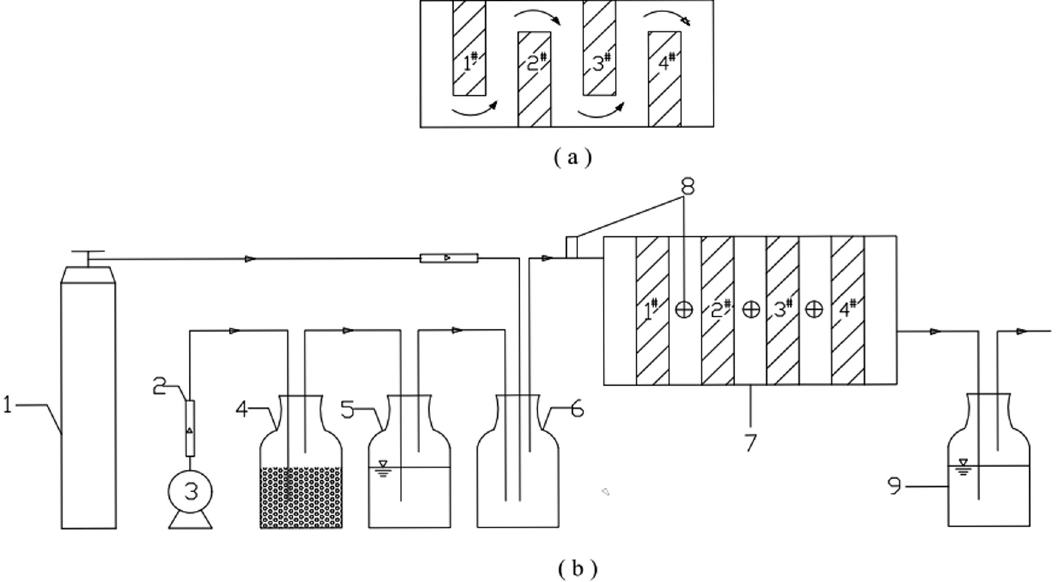
Figure 1: ( a ) Vertical view of the bioreactor packed with vermicompost; “ ” : Gas fl ow direction. ( b ) Schematic diagram of the experimental system: 1. H 2 S cylinder; 2. fl ower meter; 3. air compressor; 4. air fi lter; 5. humidi fi er; 6. expansion tank; 7. bioreactor packed with vermicompost; 8. H 2 S sampling; 9. NaOH